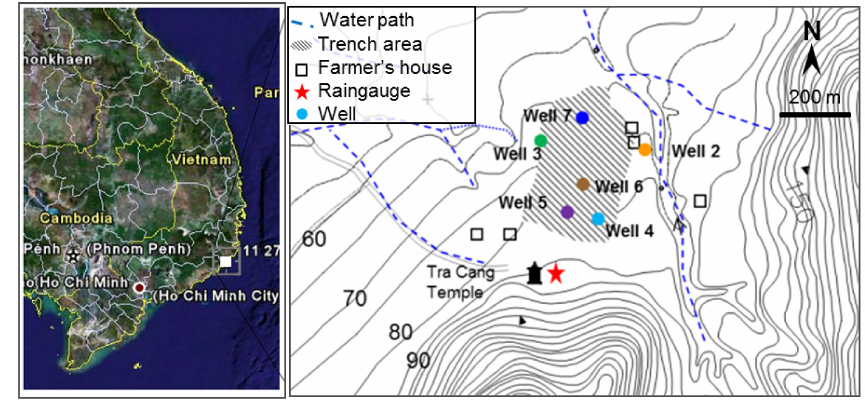
Figure 1. The location of the trenched area, rain gauge, and constructed wells. The study area is the shaded area on the lower map. Source: lo- cally produced map and Google